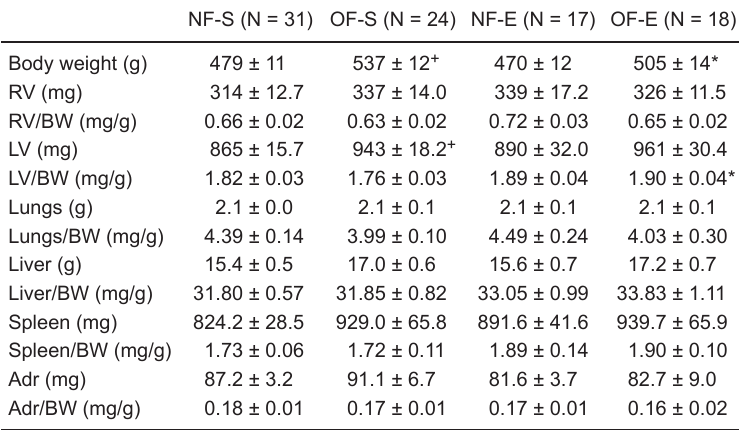
Table 1. Body weight and wet visceral weight of the four groups of